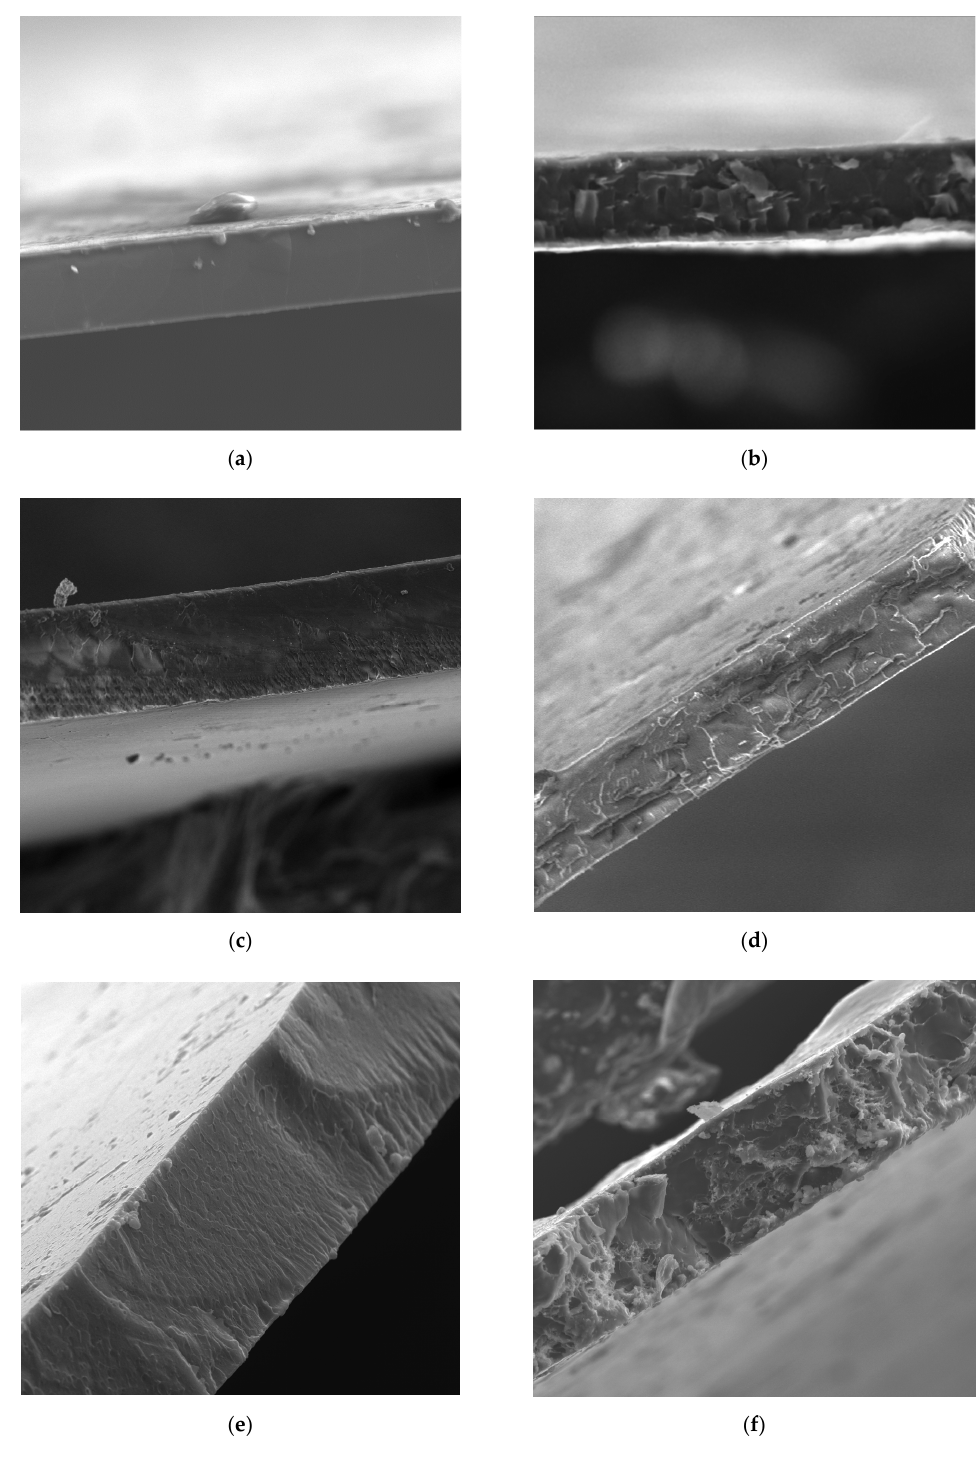
Figure 2. Cross-sectional SEM images of ( a ) Nafion, ( b ) Nafion/LDH, ( c ) sPEEK, ( d ) sPEEK/LDH, ( e ) sPSU, and ( f ) sPSU/LDH membranes.